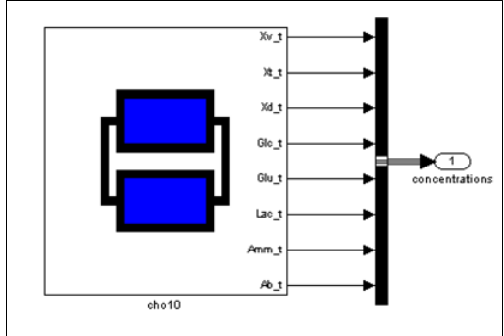
Figure 26: Simulink-model of the Petri Net model in Figure